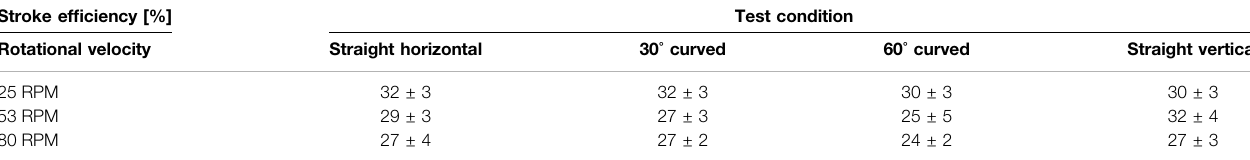
TABLE 2 | Overview of the stroke ef fi ciency [%] of the friction-based transport mechanism for different shaft orientations, curvatures and rotational velocities. Stroke ef fi ciency